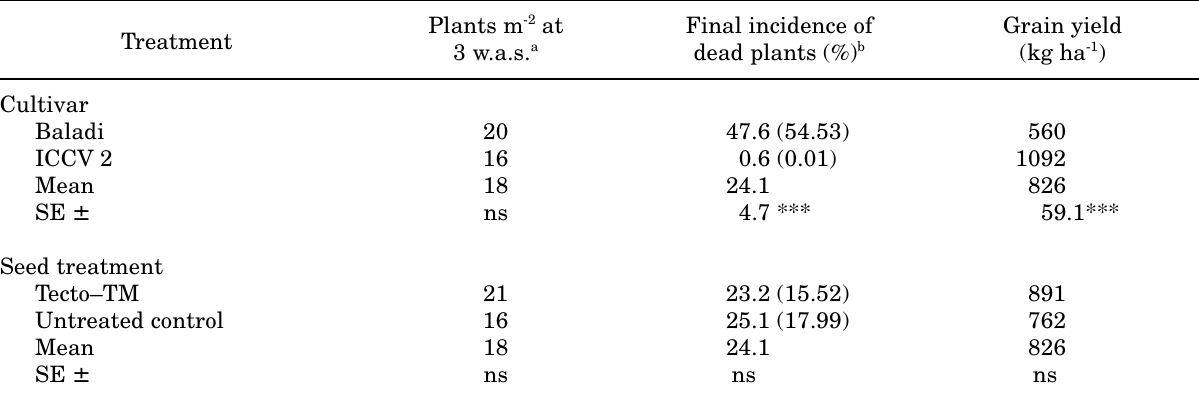
Table 3. Effect of chickpea cultivar and fungicide seed treatment on crop stand, wilt incidence and grain yield in farmers’ fields at Wad Hamid basin, northern Sudan in